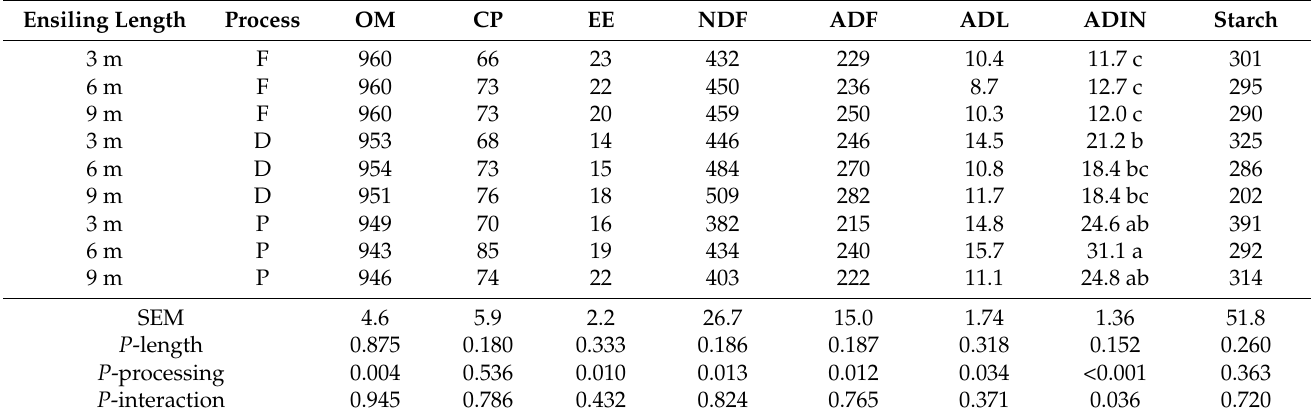
Table 2. Chemical composition (g/kg DM) of silages opened after 3, 6, and 9 months, before (F) and after heat processing (dehydrated, D, or dehydrated and pelleted, P).